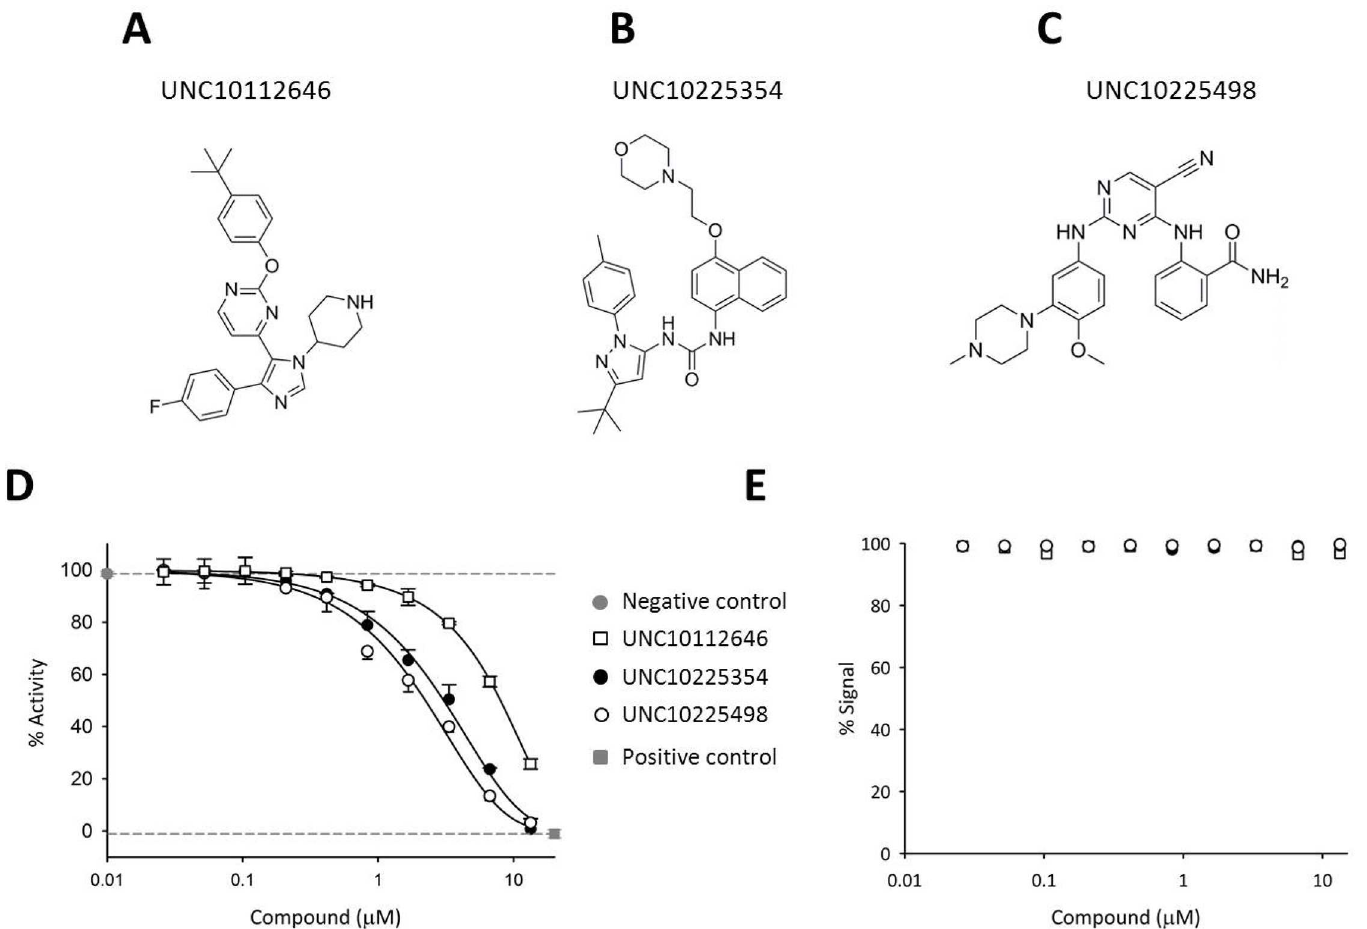
Fig 4. Structures and dose-response relationships for three inhibitors of PPIP5Ks. Structures for (A) UNC10112646 (B) UNC10225354 and (C) UNC10225498 (D) Dose-response curves for the inhibitionof PPIP5K by UNC10225354 (IC 50 = 5.24 ± 0.18 μ M), UNC10225498(IC 50 = 2.14 ± 0.07 μ M), and UNC10112646 (IC 50 = 6.96 ± 0.03 μ M). (E) Counterscreen results for the three inhibitorsperformed in the absence of PPIP5K and 5-InsP 7 show that these inhibitorsdo not interfere with the detection reagents and assay signal. In these experiments, 100% activity is equivalentto consumption of 19.5 ± 0.8% of the